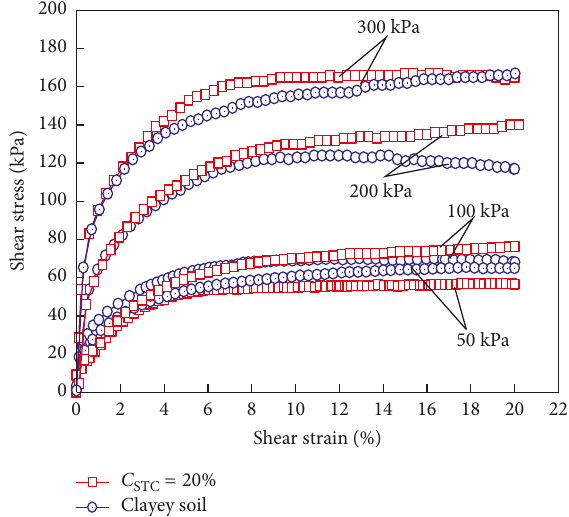
Figure 5: Variations of shear stress versus shear strain for mixtures.